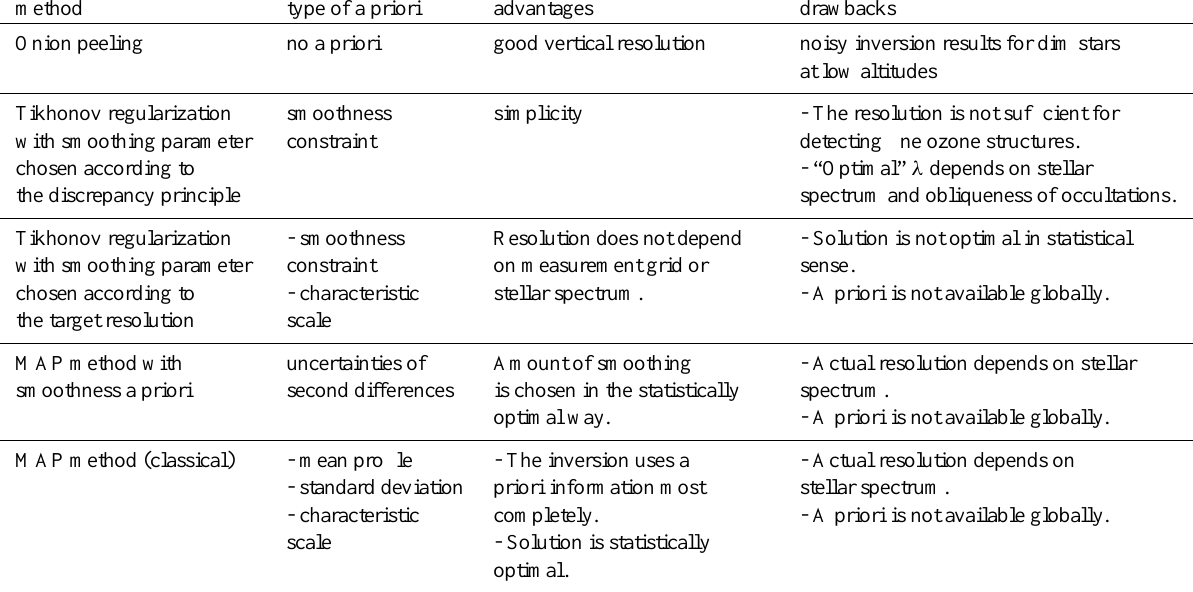
Table 2. Summary of inversion